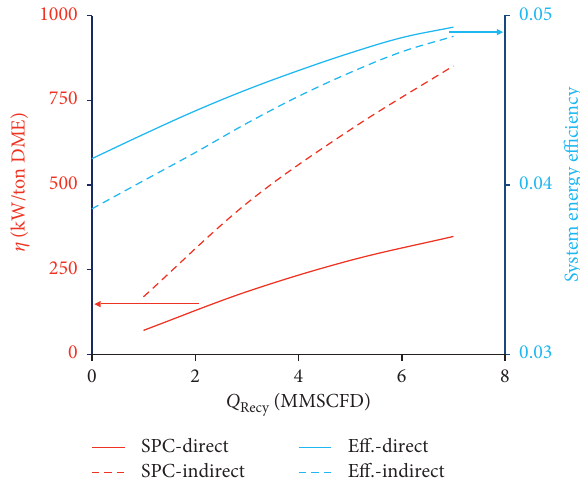
Figure 11: Effects of unreacted gas recycle rates on specific power consumption (SPC) and system energy efficiency at peak DME condition for indirect and direct